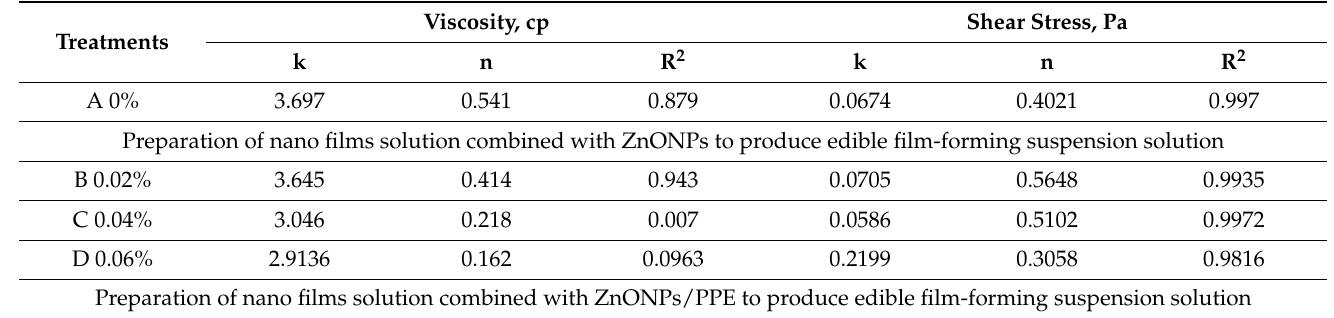
Table 2. Shows the relationship between the flow behaviour index (n) and the consistency index (k) at various treatments. Preparation of prepared chitosan nanofilm solution combined with ZnONPs and ZnONPs/PPE to produce an edible film-forming suspension solution: A 0%, B 0.04%, C